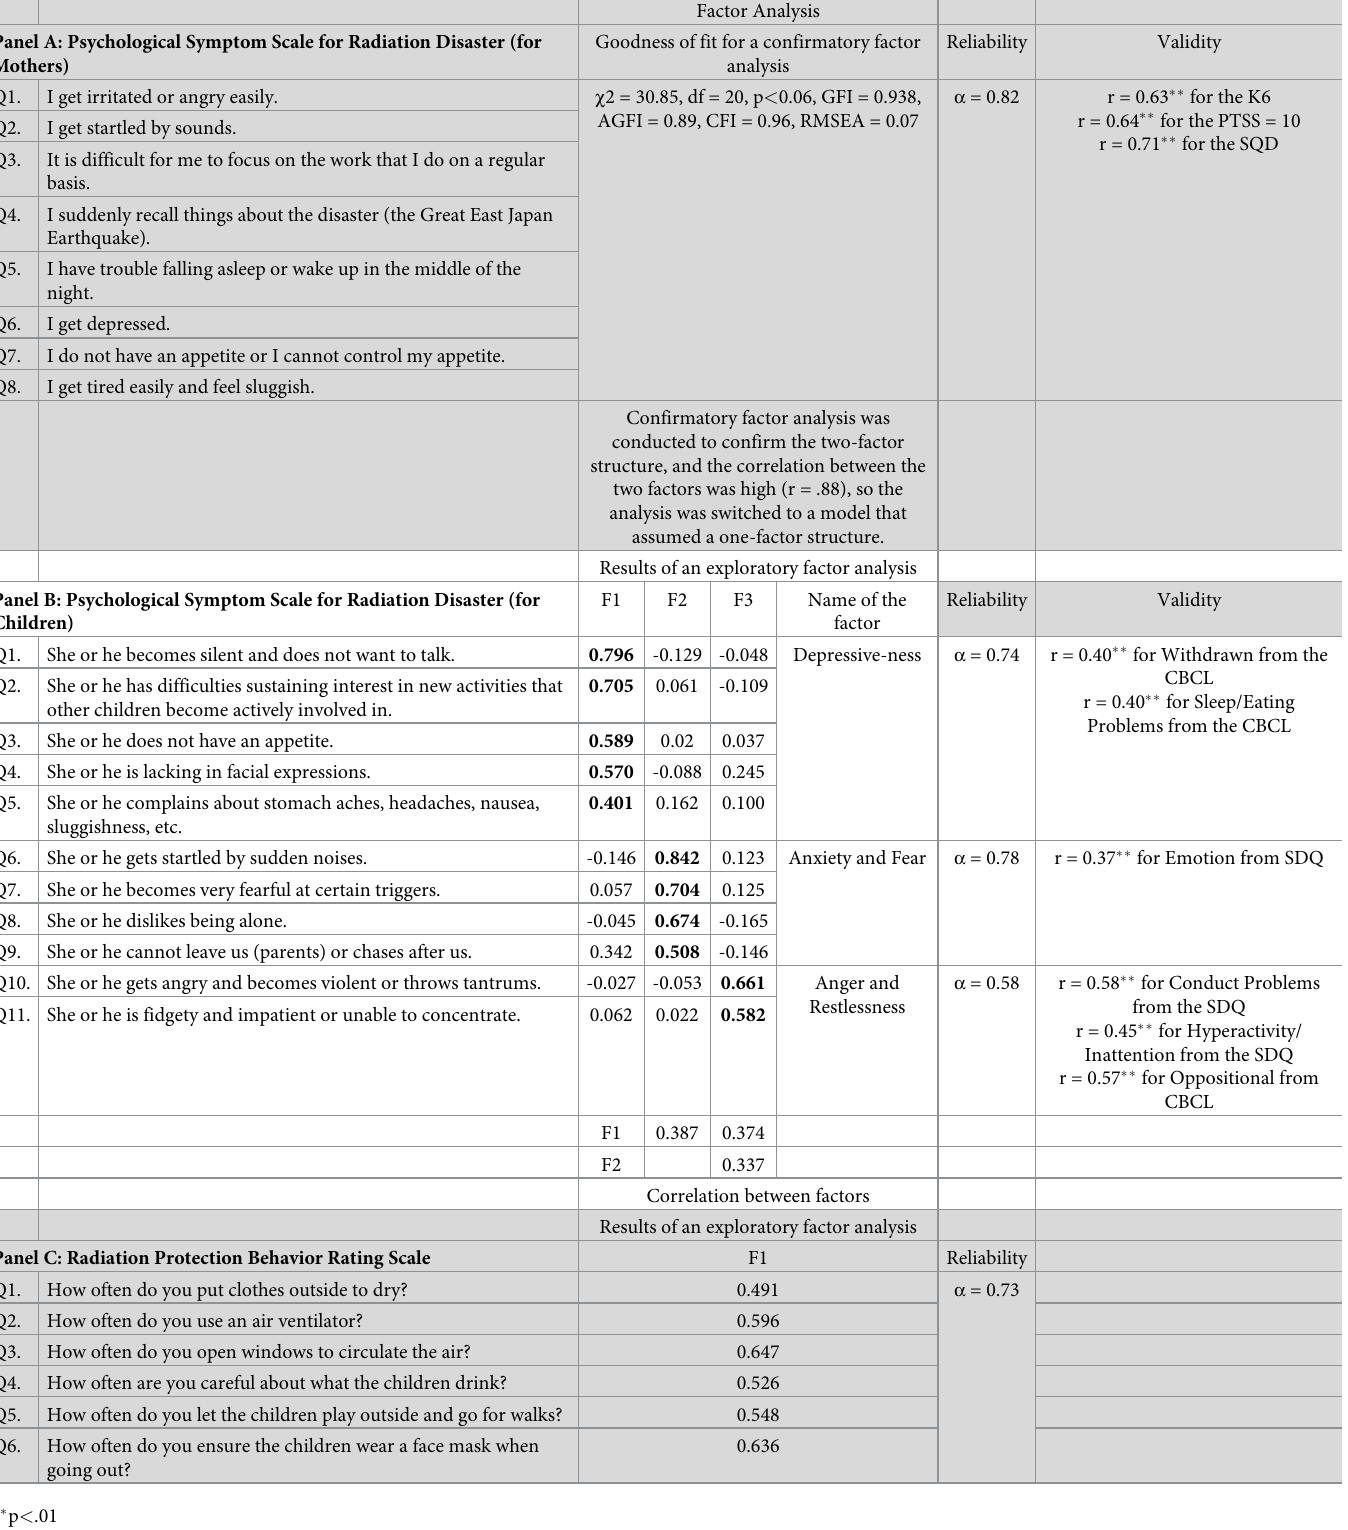
Table 1. Questionnaire items and results of factor analysis and reliability and validity